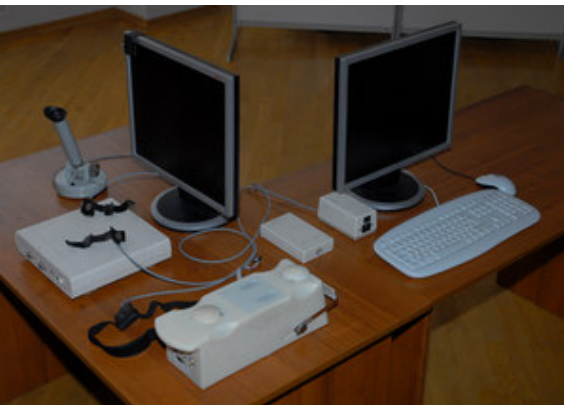
Fig 1. Multichannel computer complex